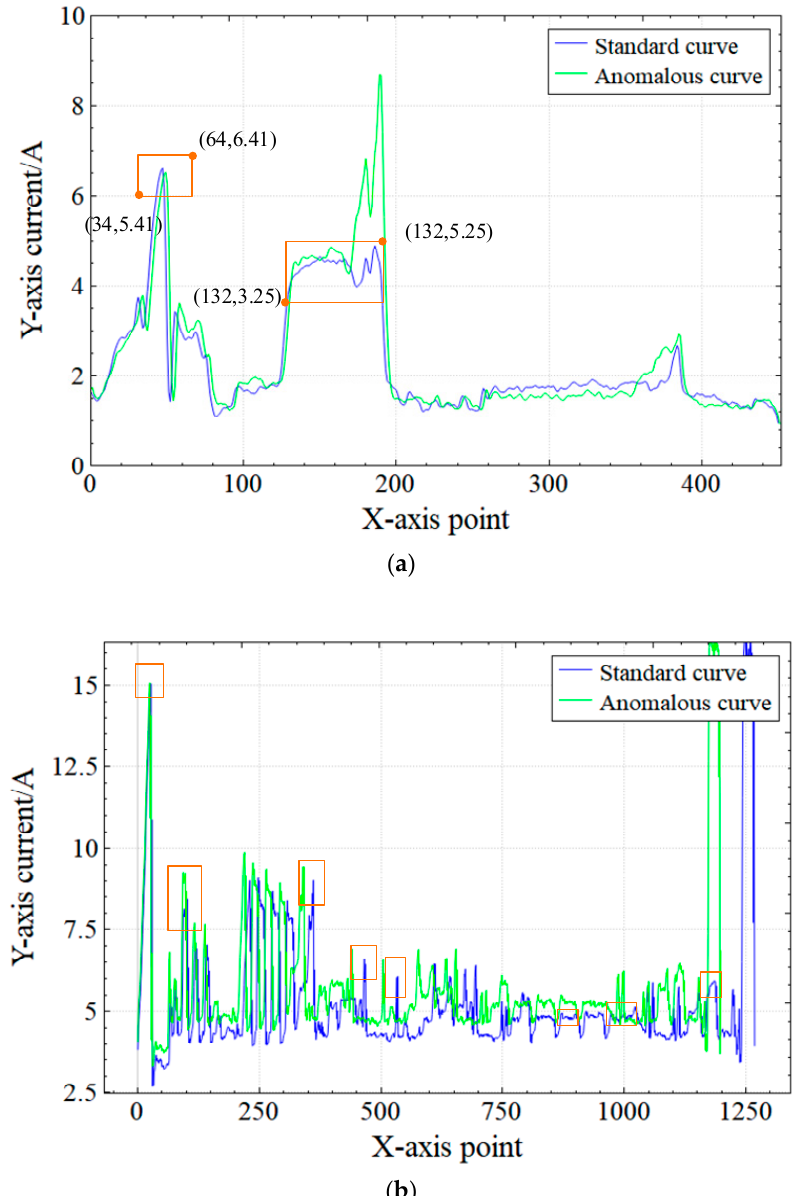
Figure 7. Comparison of standard and anomalous curve: ( a ) Tool-crashing anomaly; ( b ) Override changing anomaly.